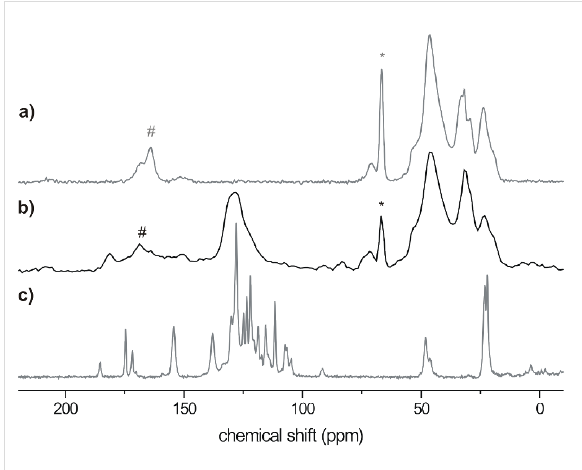
Figure 1: Solid state 13 C-{ 1 H}-CP-MAS NMR spectra of pure PVAm (a), functionalized PVAm 1-P (b) and the model compound 1-M (c) [“*” indicates the signals of the methine carbon of poly(vinyl alcohol) (PVA) and “#” corresponds to non-hydrolized formamido groups still present in the PVAm